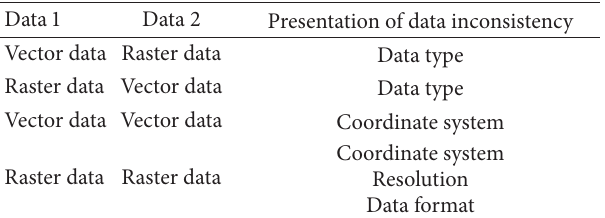
Table 1: Data inconsistency of two data